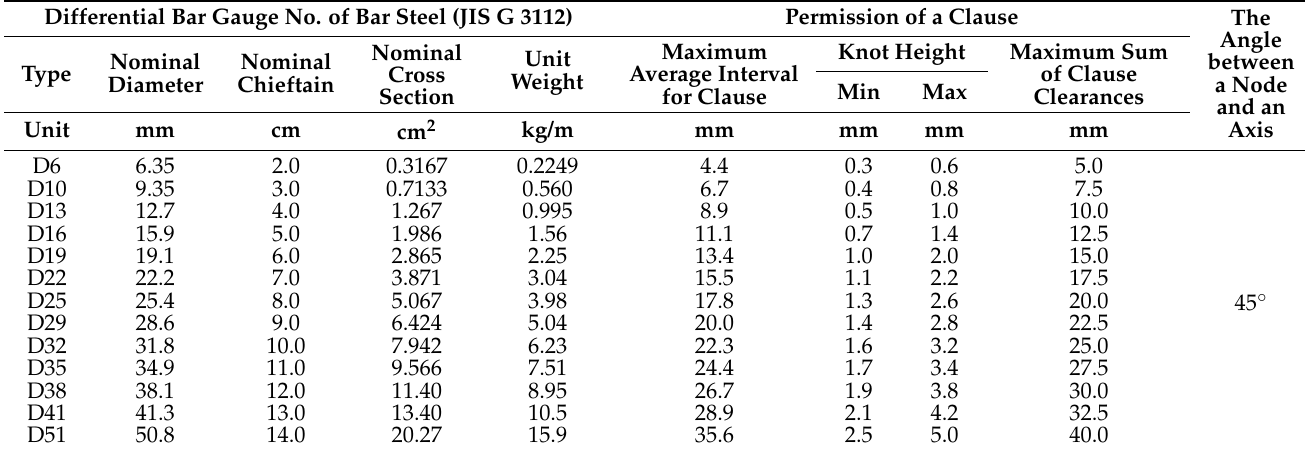
Table 1. Dimensions, types, and mechanical properties of deformed steel bar.